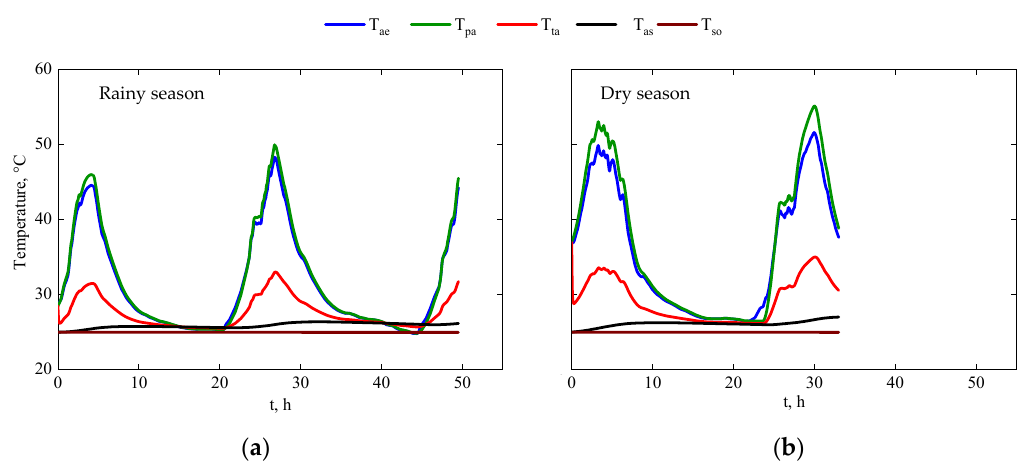
Figure 10. The simulated temperatures during the rainy season (22 November 2011) ( a ) and the dry season (4 June 2012) ( b ); temperature: air exiting the paddy rice surface T ae , paddy rice T pa , PVC tarpaulin T ta , asphalt T as , and soil T so .